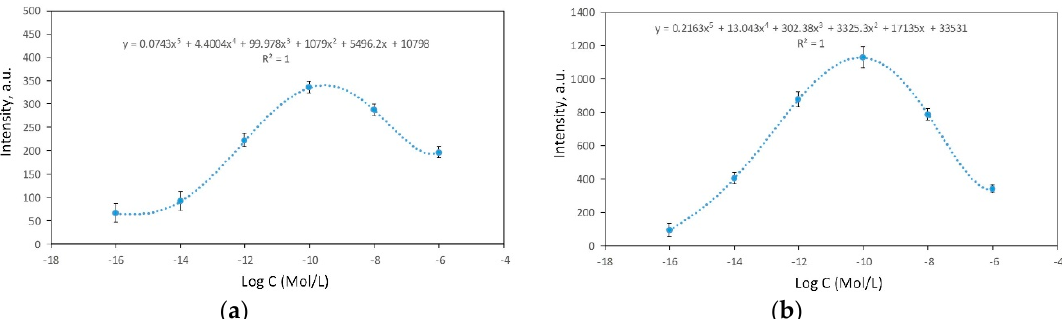
Figure 10. The calibration curves of the SERS intensities at the ( a ) 1005 and ( b ) 1290 cm –1 bands vs. the lactoferrin concentration. The curves were calculated using a polynomial fitting of the fifth order.